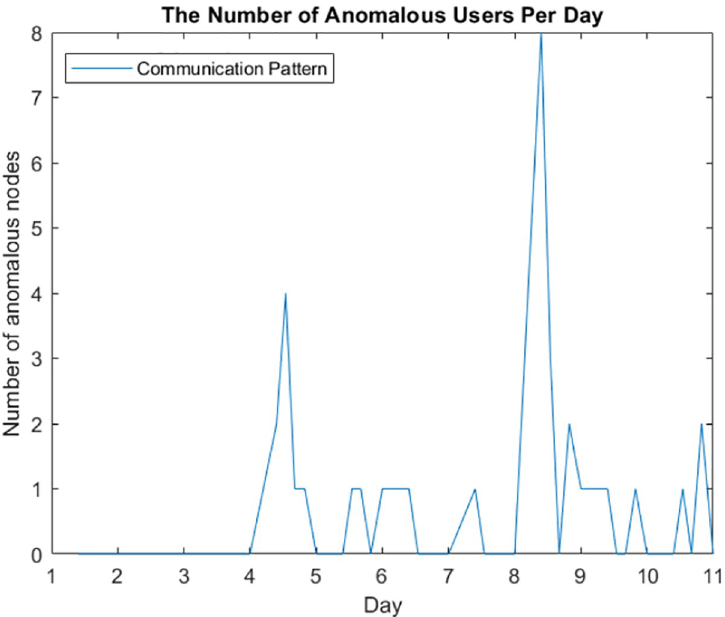
Fig 16. Number of anomalous nodes in each daily time interval under a Markov Bernoulli model.